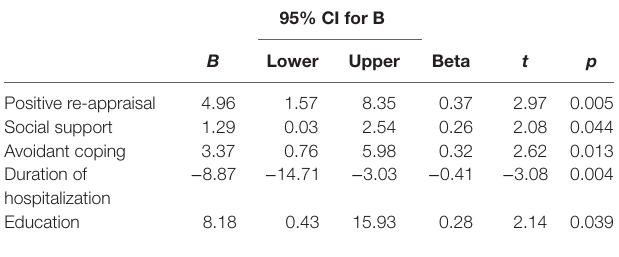
TaBle 3 | Stepwise regression with quality of life as the dependent variable.